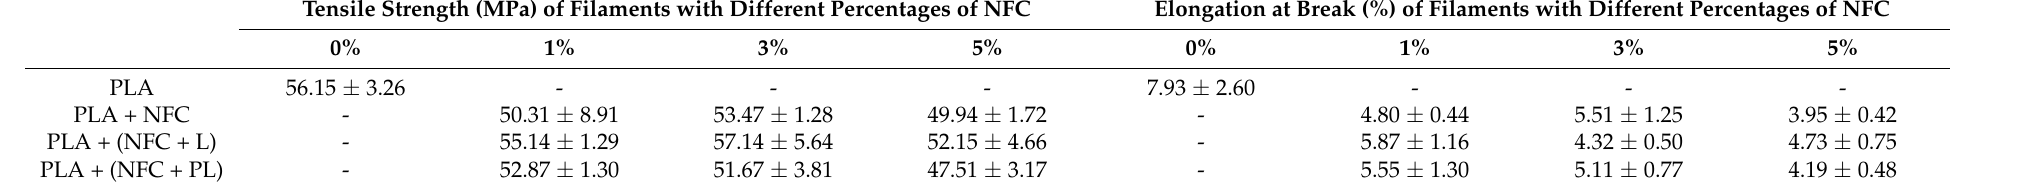
Table 3. Tensile strength and elongation at break of filaments; mean value ± SD.